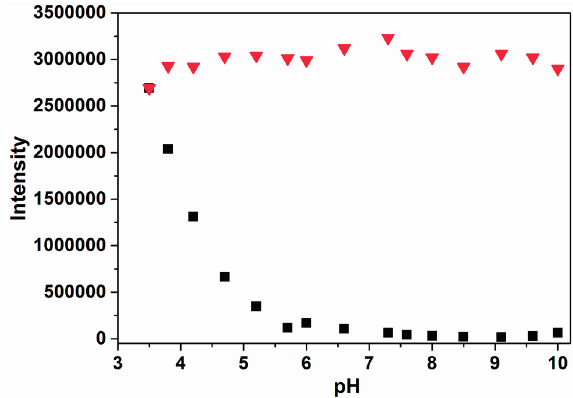
Figure 1. Influence of pH on the fluorescence spetra of P (2 μ M, ■ ) and P (2 μ M, ▼ ) plus Cu 2+ (50 μ M) in ethanol-water solution (3:2, v:v). The pH was modulated by adding 1 M HCl or 1 M NaOH in HEPES